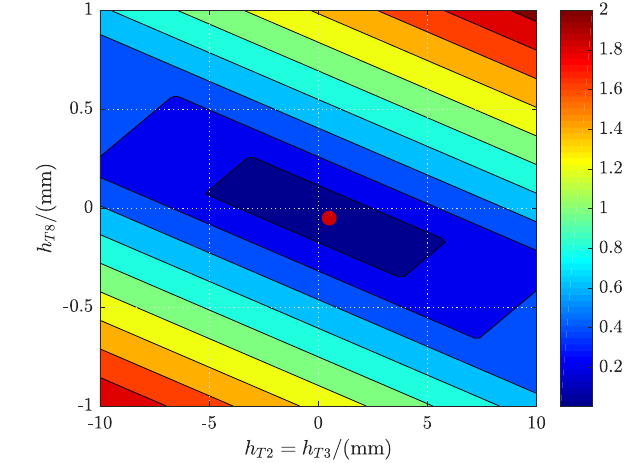
Figure 9. FEA results of the function | C |+| D | in step 3 with = 3 . 682mm (matrices for C and D normalized). The red dot h ∗ HG indicates the optimal adjustment with h ∗ ≈ − 0 . 046mm. h ∗ T 8 Table 3. Adjustments of the FEA model.